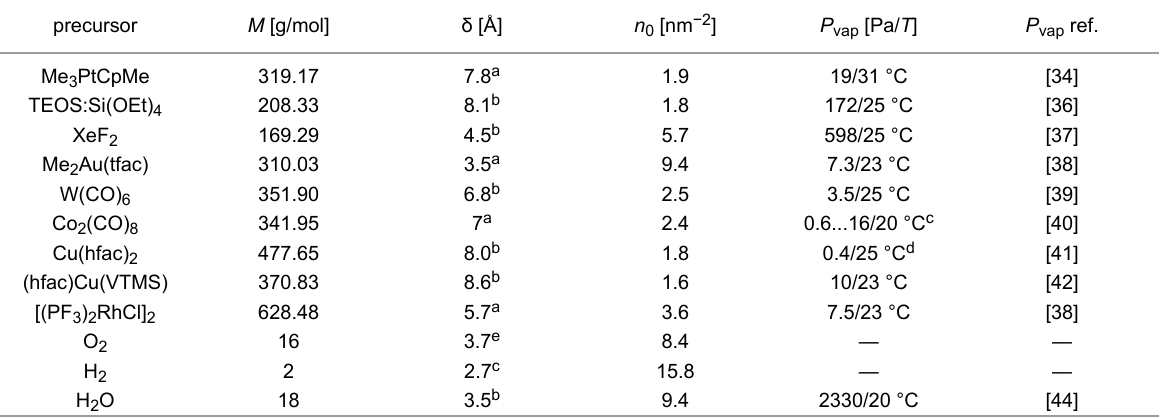
Table 2: Summary of molecule diameters ( δ ), molar masses ( M ), vapour pressures P vap and monolayer adsorbate concentrations n 0 of selected FEBIP precursors. The latter were calculated using n 0 = 1.154 δ − 2 .